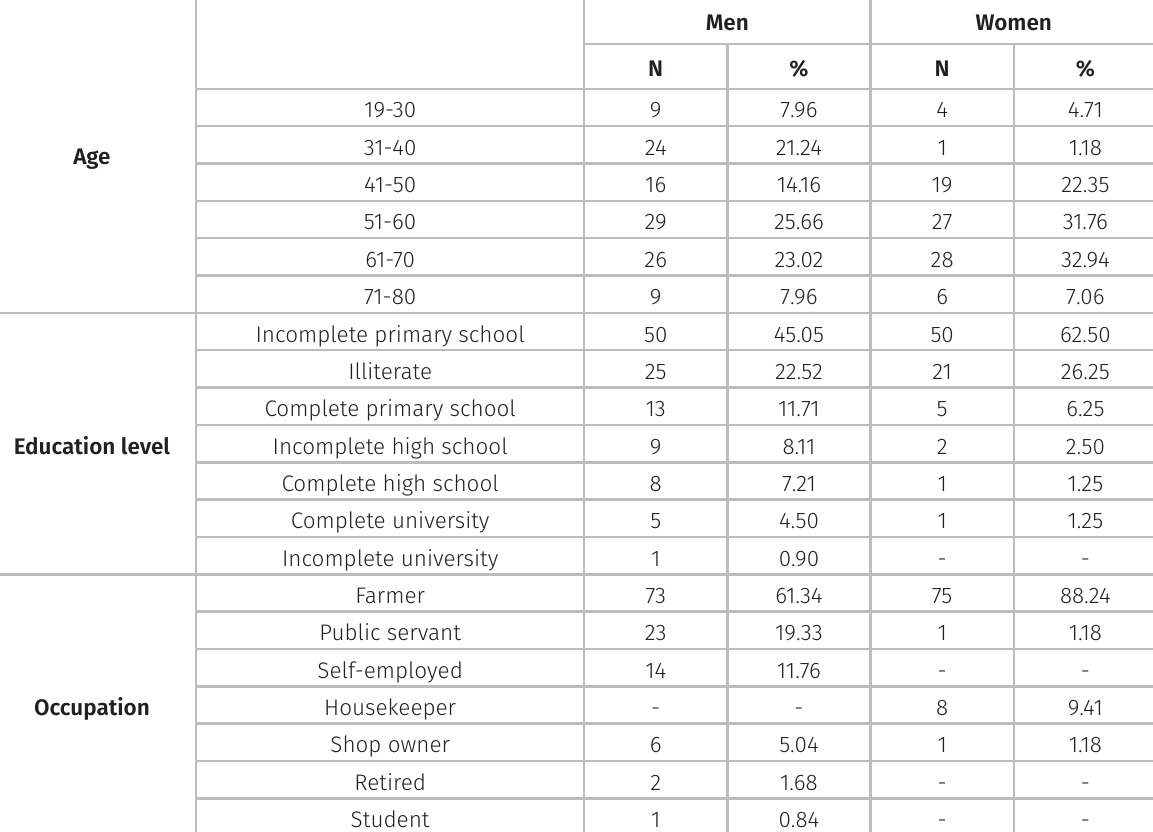
Table I. S ocioeconomic aspects of respondents in study areas in Agreste and coastal forest zone of state of Pernambuco, Brazil (N;